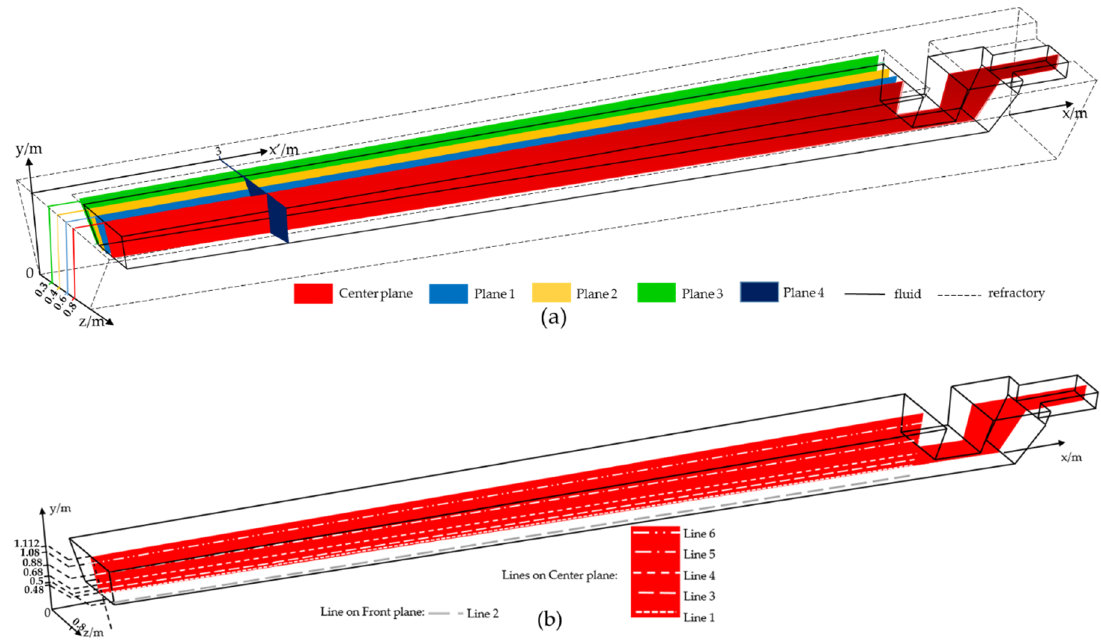
Figure 3. Locations of 5 faces and 6 lines in the main trough for post-processing analysis: ( a ) planes in the full main trough, ( b ) lines in the mixture fluid of the main trough.